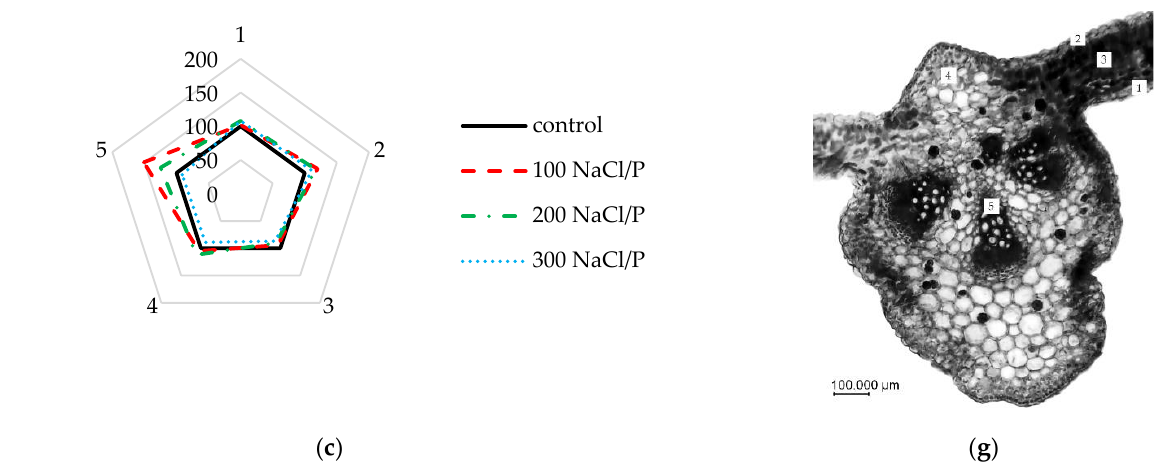
Figure 4. Morphometric parameters of leaves of young Chenopodium quinoa exposed to abiotic stress of varying intensity: ( a ) osmotic stress; ( b ) salt stress; ( c ) combined stress; ( d ) cross-sections through control quinoa leaf; ( e ) cross-sections through control quinoa leaf under P; ( f ) cross-sections through control quinoa leaf under 200NaCl; ( g ) cross-sections through quinoa leaf under 200NaCl/P; 1, the thickness of the adaxial epidermis; 2, the thickness of the abaxial epidermis; 3, the thickness of the mesophyll; 4, the thickness of the central vein; 5, the diameter of the central vascular bundle. The data presented in Figures 5 and 6 indicate that stress conditions affect the size of the stem parenchyma and vascular tissue, which in turn affects the stem growth of young plants.